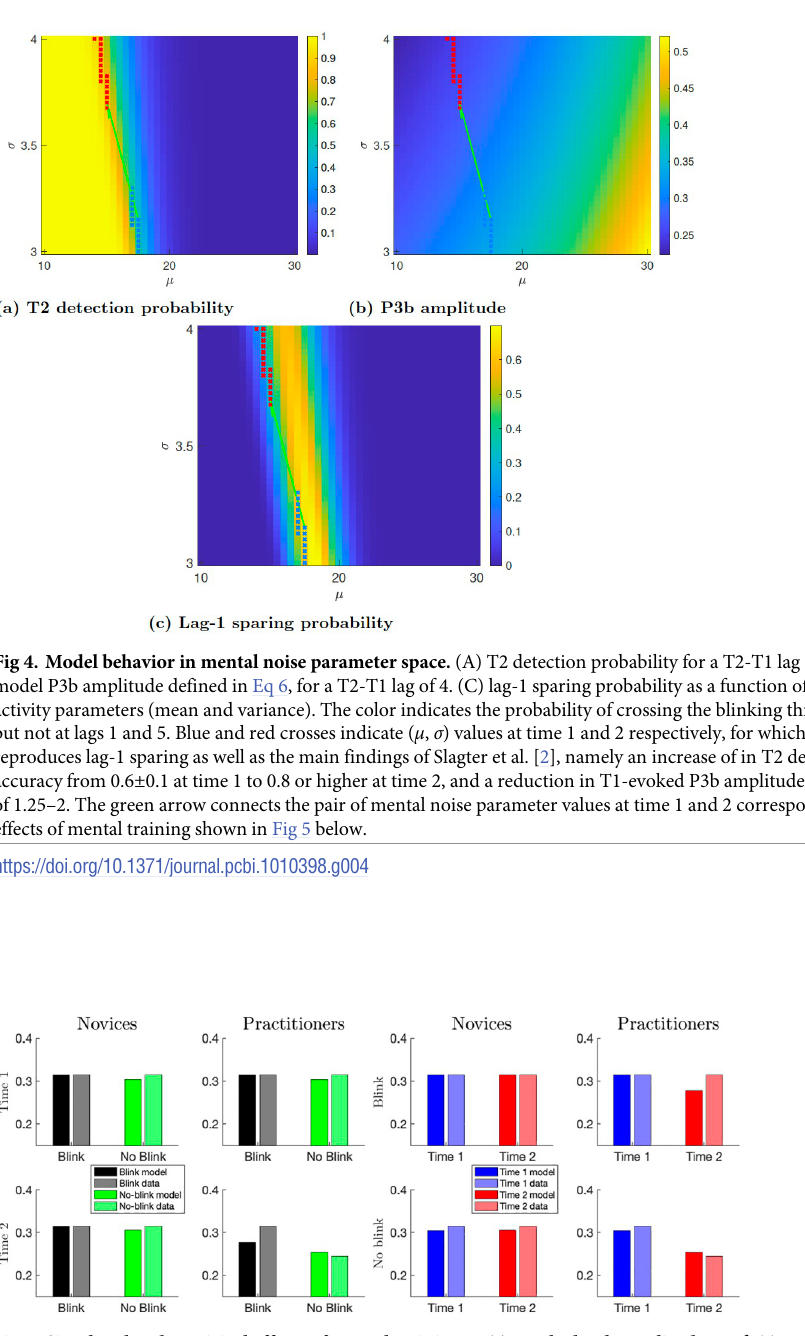
Fig 5. Simulated and empirical effects of mental training on T1-evoked P3b amplitudes. Left: T1-evoked P3b amplitude as a function of T2 detection (blink or no-blink), session (time 1 or time 2), and group (practitioners or novices). Meditation practitioners show a greater reduction in T1-evoked P3b amplitude compared to novices in no- blink vs blink trials at time 2 vs time 1. Right: Selective reduction in T1-evoked P3b amplitude in no-blink trials in the practitioner group. Mental noise mean and standard deviation levels ( μ , σ ), for practitioners: (17.5, 3.15) at time 1 and (14.5, 3.8) at time 2. For novices: (17, 3) at both times. Colors follow figure 3 in Slagter et al. [2], whose data is replotted here.